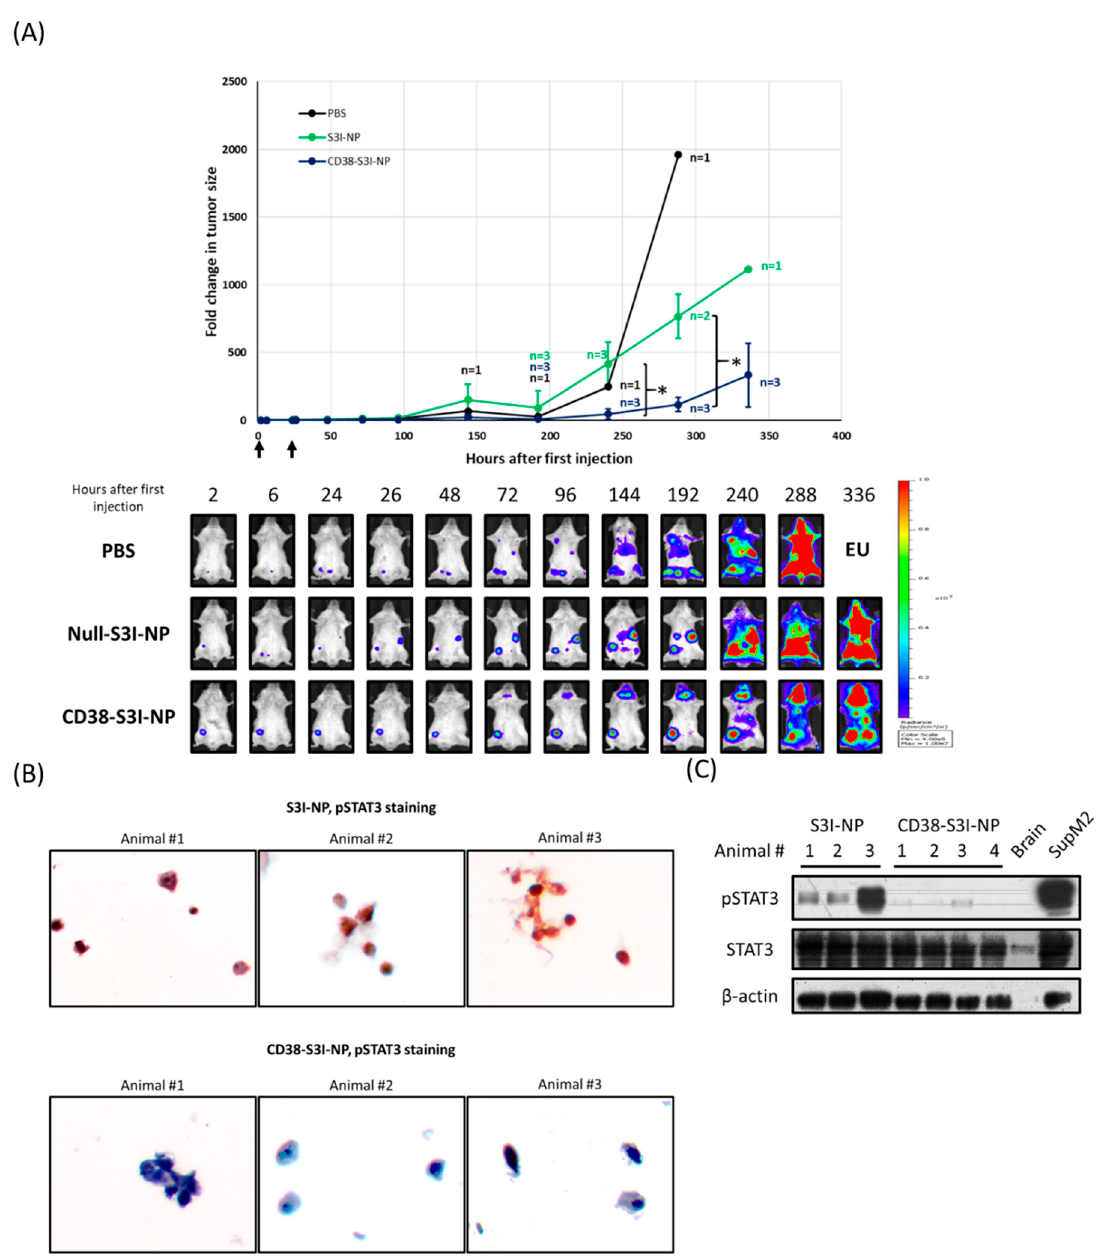
Figure 4. CD38-S3I-NP is more tumor suppressive than S3I-NP in MM xenograft. ( A ) SCID mice intravenously injected with PBS (black line, n = 2), 3 mg/kg S3I-NP (green line, n = 4) or CD38-S3I-NP (blue line, n = 4) every day for two days as indicated by arrows on the x -axis. Animal numbers other than the initial numbers at different time points are indicated. The tumor size was quantified by the bioluminescence intensity and normalized to the initial bioluminescence signal (i.e., 2 h post-injection). The representative bioluminescence images of animals treated with PBS, S3I-NP, or CD38-S3I-NP were shown. * p < 0.05, via Student’s t -test; EU—euthanized. ( B ) The pSTAT3 levels in bone marrow mononuclear cells extracted from the SCID mice in ( A ) at the endpoint. Non-tumorous brain tissue from a SCID mouse was used as a negative control. SupM2 cells were used as a positive control for pSTAT3. β -actin was blotted as a loading control. ( C ) Immunocytochemical staining of pSTAT3 and in bone marrow mononuclear cells from ( B ). Each image represents bone marrow cells from one animal. The images were taken at a magnification of 400×.